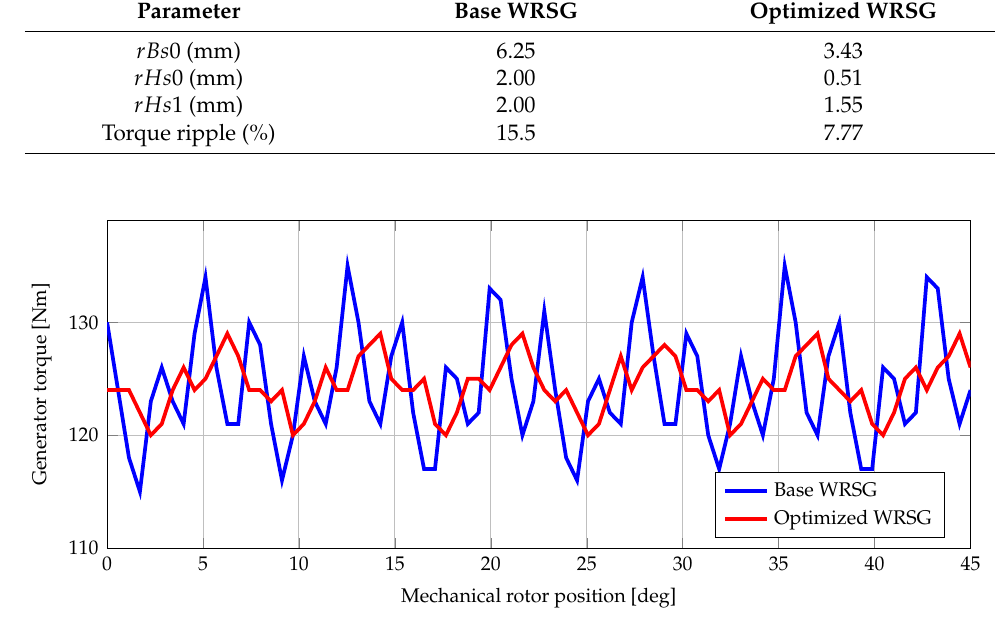
Figure 5. Generator torque versus mechanical rotor position for base- and rotor-optimized WRSG.